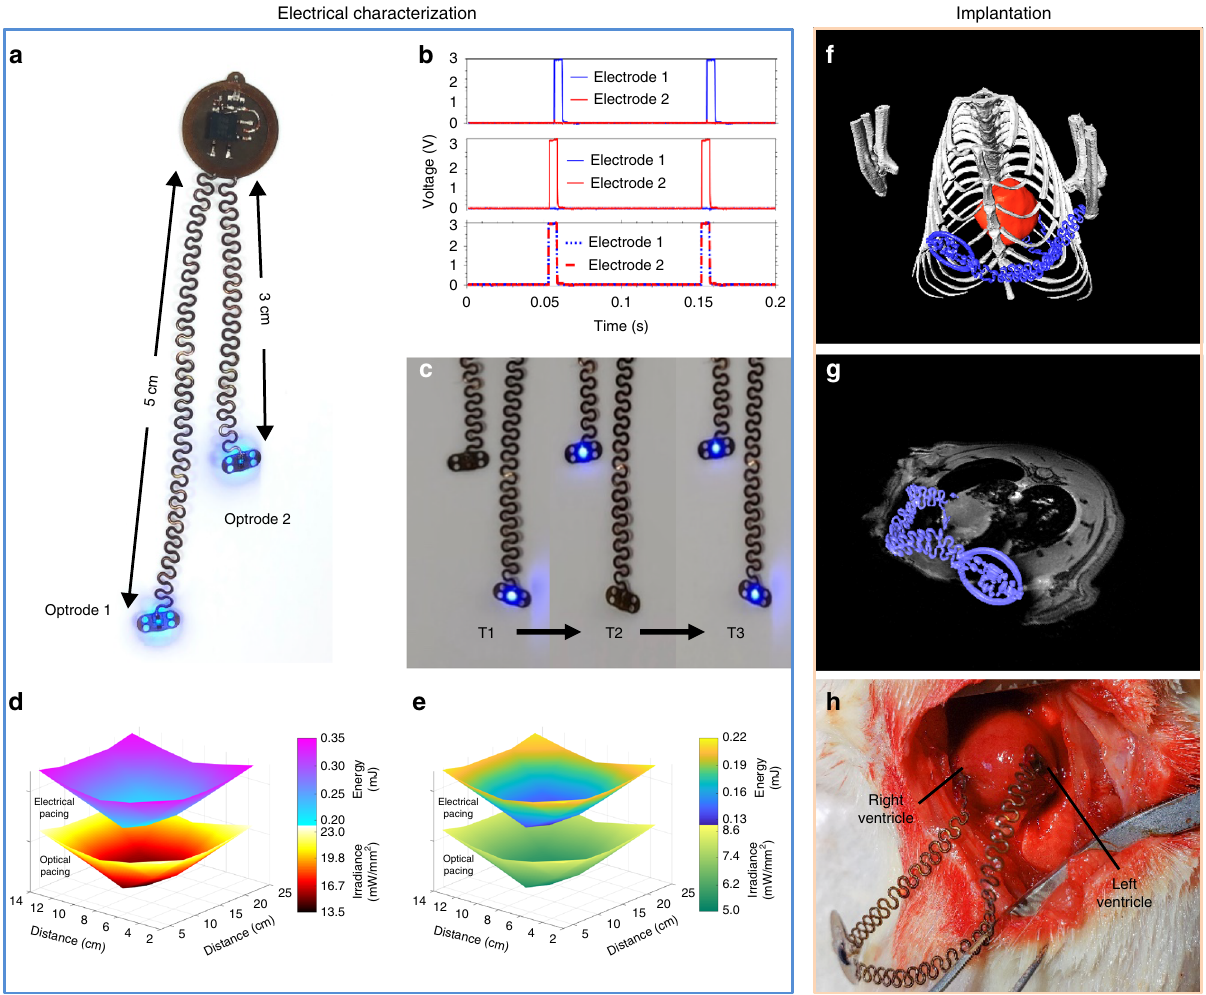
Fig. 3 Multisite pacing. a Photographic image of a bilateral optogenetic stimulator. b Time-resolved voltage of pacing electrodes in a unilateral pacing mode for electrode 1 and 2, and in a bilateral pacing mode. c Independently addressable bilateral optogenetic stimulation at intervals T1, left optrode activation, T2 right optrode activation, and T3 simultaneous activation. d Spatially resolved energy and irradiance distribution of individual optrodes for independent bilateral electrical and optical pacing in a test cage at a height of 3 cm from the fl oor. e Spatially resolved energy and irradiance distribution for individual optrodes for combined bilateral electrical and optical pacing in a test cage at a height of 3 cm from the fl oor. f 3D rendering of an implanted device in a rat derived from combined MRI and CT images. g Combined 3D CT and 2D MRI slice of a bilateral pacemaker implanted in a rat, indicating epicardial positioning of optrodes. h In vivo s urgical implantation of the device on a rat indicates the available energy and irradiance for this combined electrical and optical pacing with 5 ms pulses at a cage height of 3 cm. Supplementary Fig. 3 shows stable operation of regulated device output voltage in experimental arenas for rats.